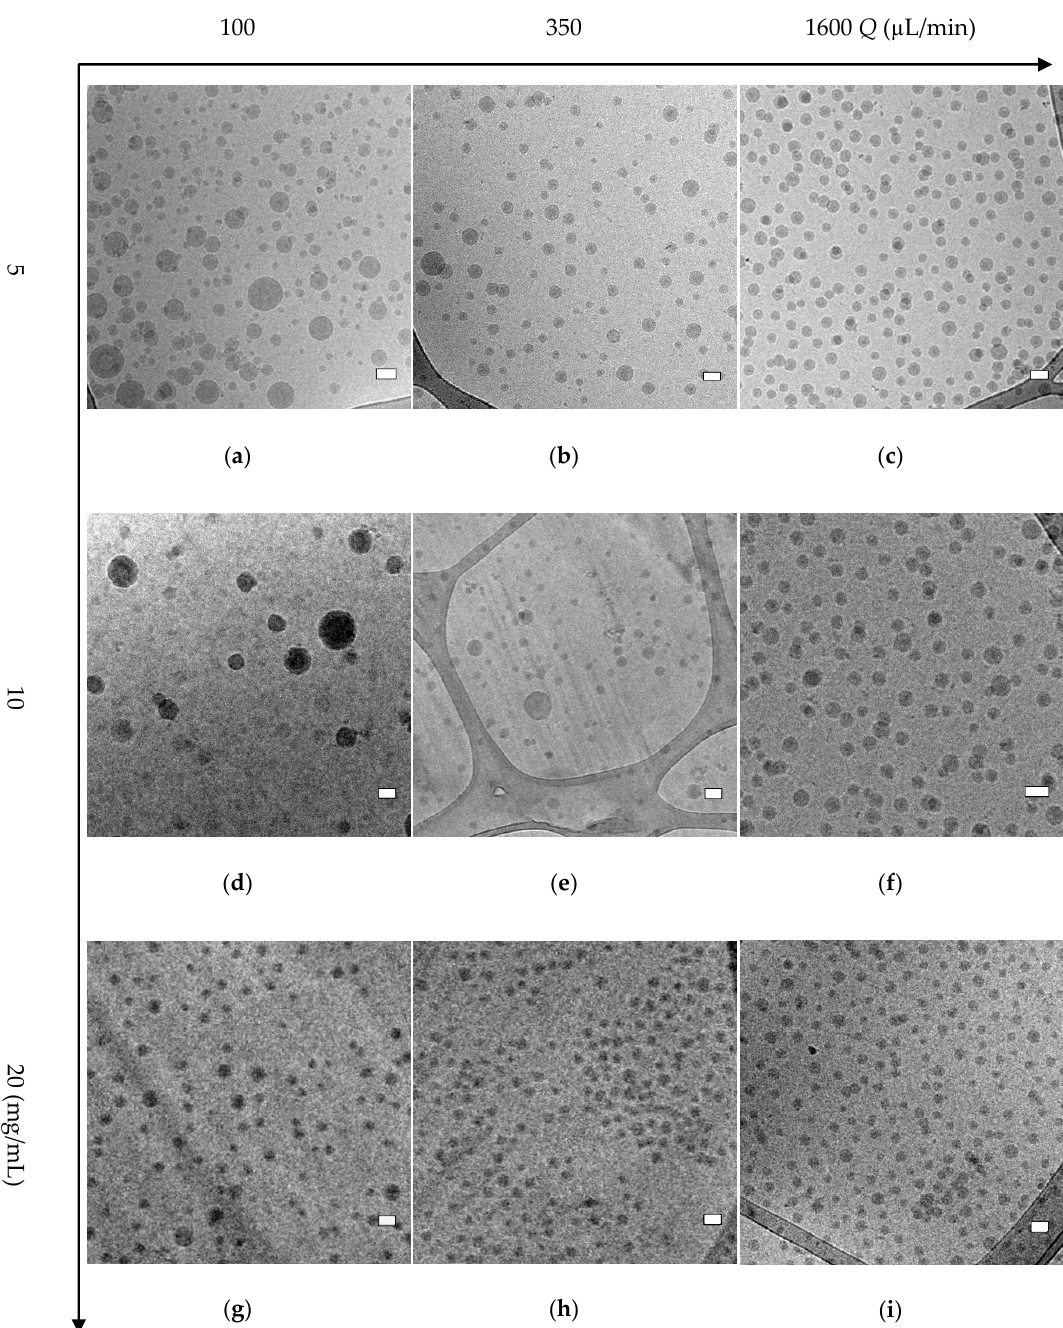
Figure 4. Cryo-TEM pictures of polymer A (mPEG 5K - b -p(HPMA-Bz) 17.1K ) nanoparticles prepared using different polymer concentrations and flow rates. ( a ) 5 mg/mL and 100 µL/min, ( b ) 5 mg/mL and using di ff erent polymer concentrations and flow rates. ( a ) 5 mg / mL and 100 µ L / min, ( b ) 5 mg / mL 350 µL/min, ( c ) 5 mg/mL and 1600 µL/min, ( d ) 10 mg/mL and 100 µL/min, ( e ) 10 mg/mL and 350 and 350 µ L / min, ( c ) 5 mg / mL and 1600 µ L / min, ( d ) 10 mg / mL and 100 µ L / min, ( e ) 10 mg / mL and µL/min, ( f ) 10 mg/mL and 1600 µL/min, ( g ) 20 mg/mL and 100 µL/min, ( h ) 20 mg/mL and 350 µL/min, 350 µ L / min, ( f ) 10 mg / mL and 1600 µ L / min, ( g ) 20 mg / mL and 100 µ L / min, ( h ) 20 mg / mL and 350 µ L / min, ( i ) 20 mg/mL and 1600 µL/min. Scale bars indicate 50 nm. ( i ) 20 mg / mL and 1600 µ L / min. Scale bars indicate 50